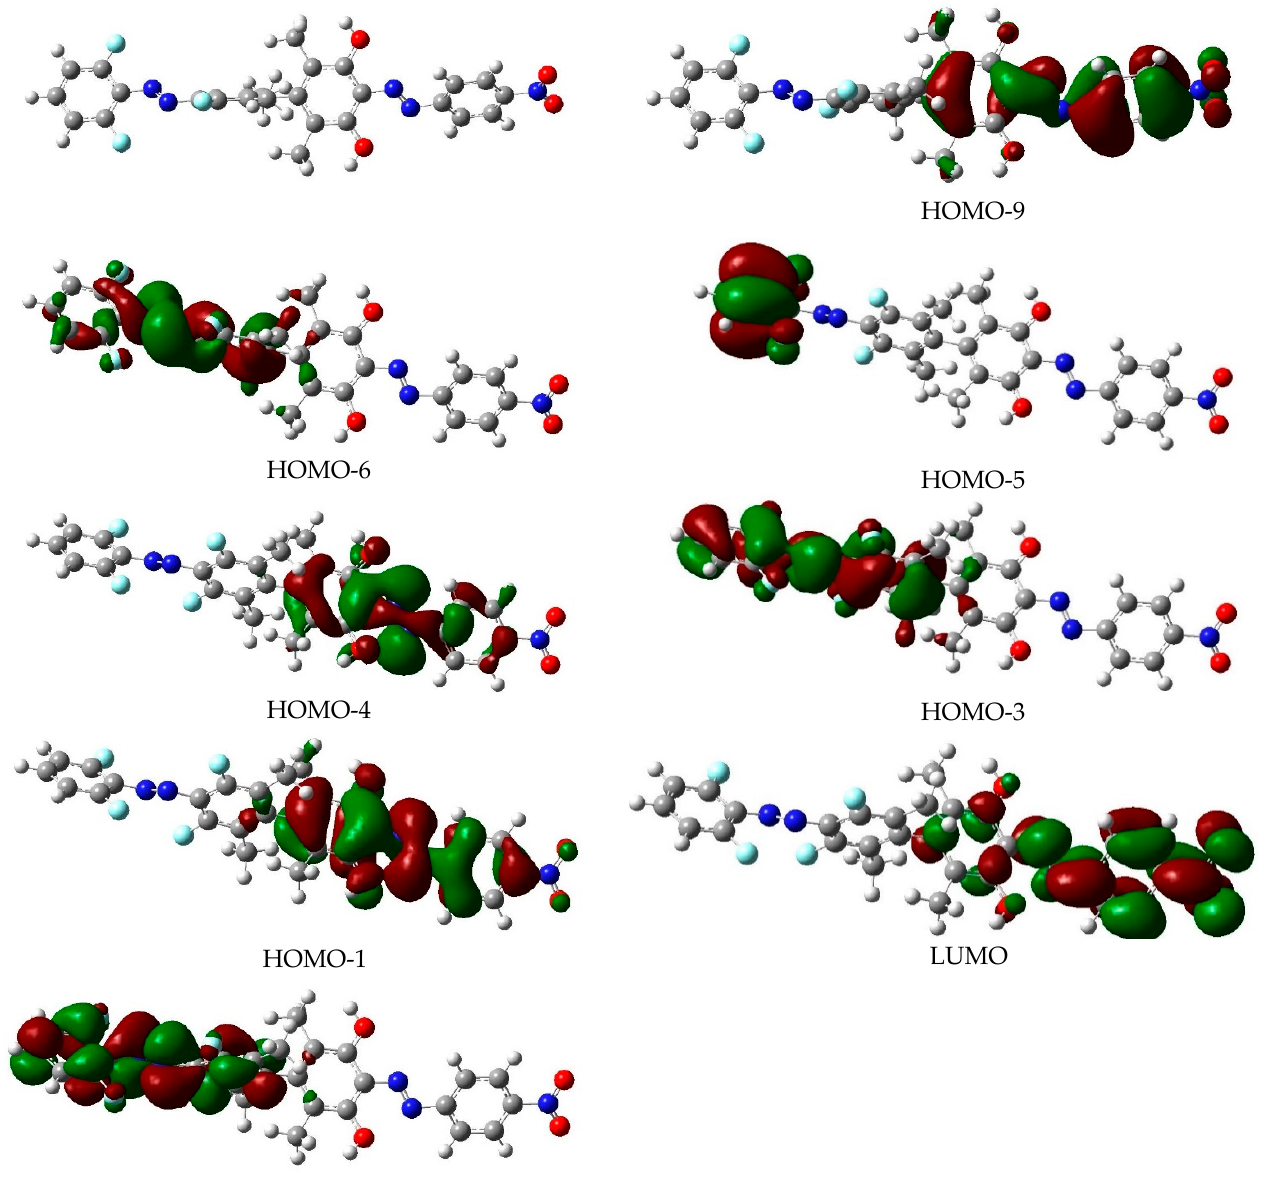
Figure 7. Shape of the molecular orbitals involved in the relevant excited electronic states of the EE isomer of dimer 2. The drawings correspond to an iso-level of 0.02 a.u. of electronic density. The left top corner of the Figure depicts the molecular structure of the EE isomer.